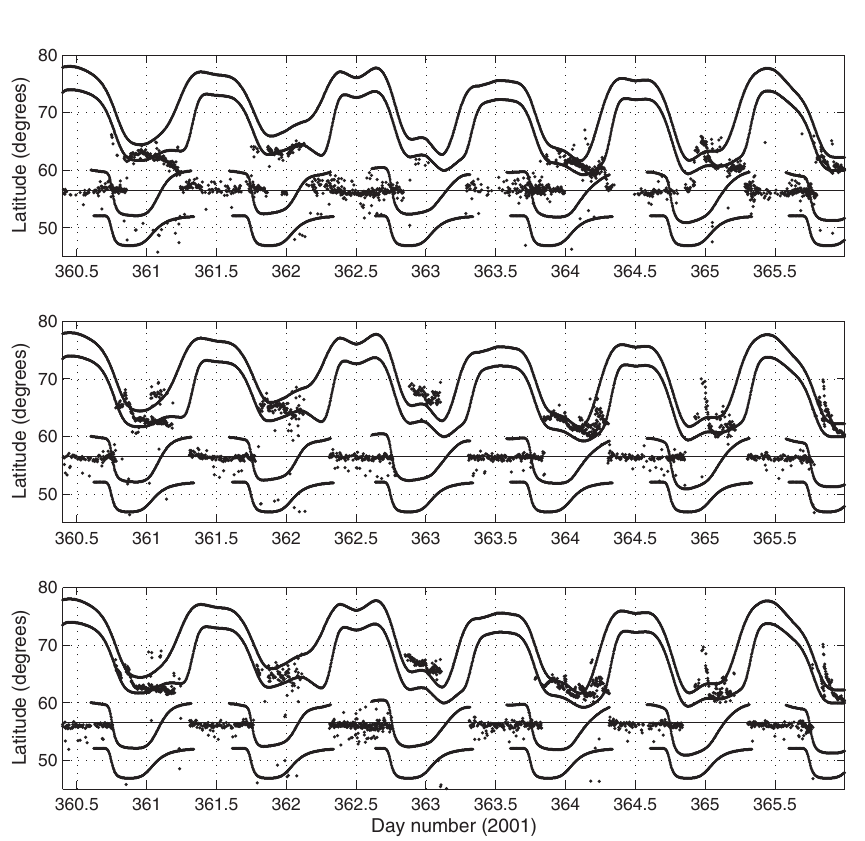
Fig. 14.5. The latitude of the calculated point of virtual reflection and of the model trough walls between noon on 26th December 2001 (day 360) and the end of 31st December 2001 (day 365). From top to bottom: frequen- cy 7.0, 10.4 and 11.1 MHz. The horizontal line at 56.5 o N represents the latitude of the mid-point of the